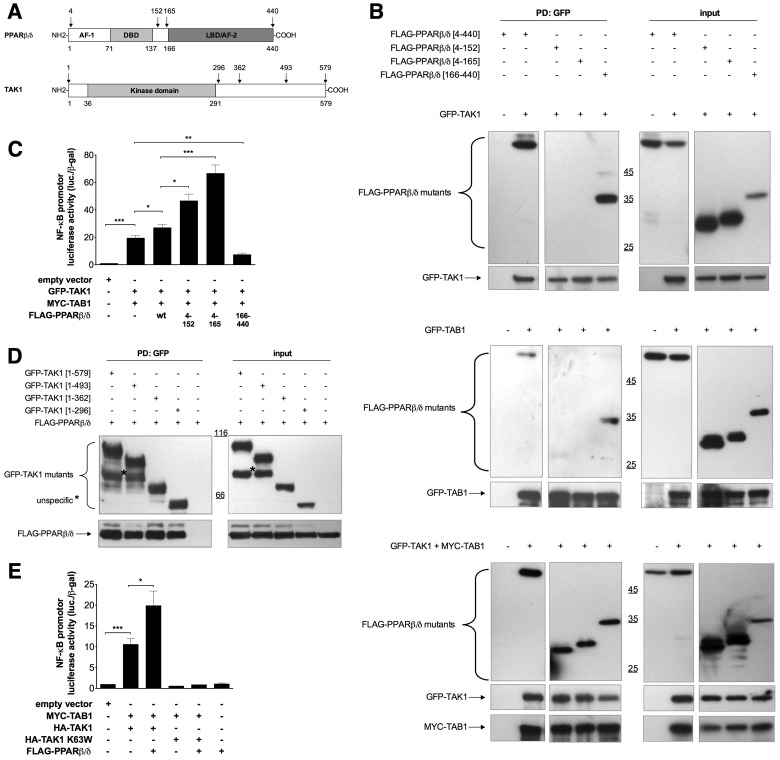
Identification of PPARβ/δ and TAK1 domains involved in their physical and functional interactions.(A) Domain structure of PPARβ/δ and TAK1. Deletion mutants were constructed as to preserve or remove specific domains in PPARβ/δ (N-terminal activation domain AF1, DNA-binding domain DBD, ligand binding activation domain LBD/AF2 or the hinge region between the DBD and the LBD/AF2 domains) and in TAK1 (kinase domain). Additional truncations at the C-terminus of TAK-1 mimic known splice variants [65]. (B) Interaction of PPARβ/δ deletion mutants with TAK1 and TAB1. Experimental details were as in Figure 6A. (C) Effect of PPARβ/δ deletion mutants on TAK1/TAB1 induced NFκB activity. Experimental details were as in Figure 5E. (D) Interaction of TAK1 deletion mutants with PPARβ/δ. Experimental details were as in Figure 6A. (E) Dependence of the PPARβ/δ enhancement of NFκB activity on catalytically active TAK1. Values represent averages ±SD (n = 3–5). ***, **, *significant differences between samples as indicated (p<0.001, p<0.01, p<0.05 by t-test).